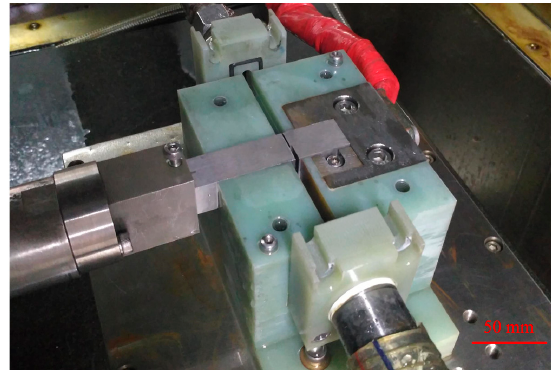
Figure 9. Photograph of the ECM fixture and important components of experimental apparatus.